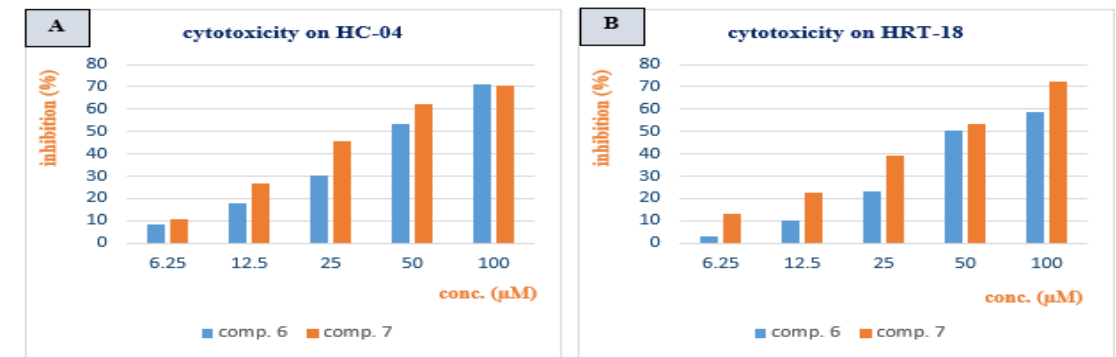
Figure 5. Histogram showing the concentration and growth inhibition of the compounds 6 and 7, (A): against hepatic carcinoma cells and (B): against colon